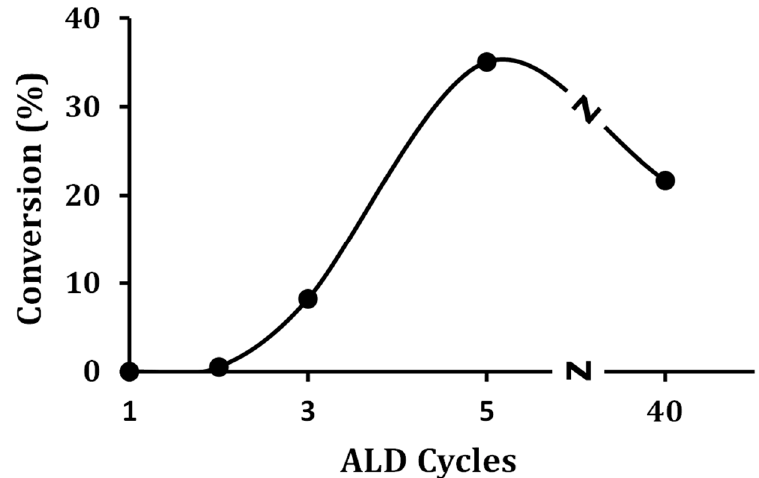
Figure 8. The 2-propanol conversions on x W-Zr (where x is the number of ALD cycles) samples for the steady-state dehydration reaction at 403 K. Reaction conditions: 2-propanol WHSV = 0.40 h − 1 .